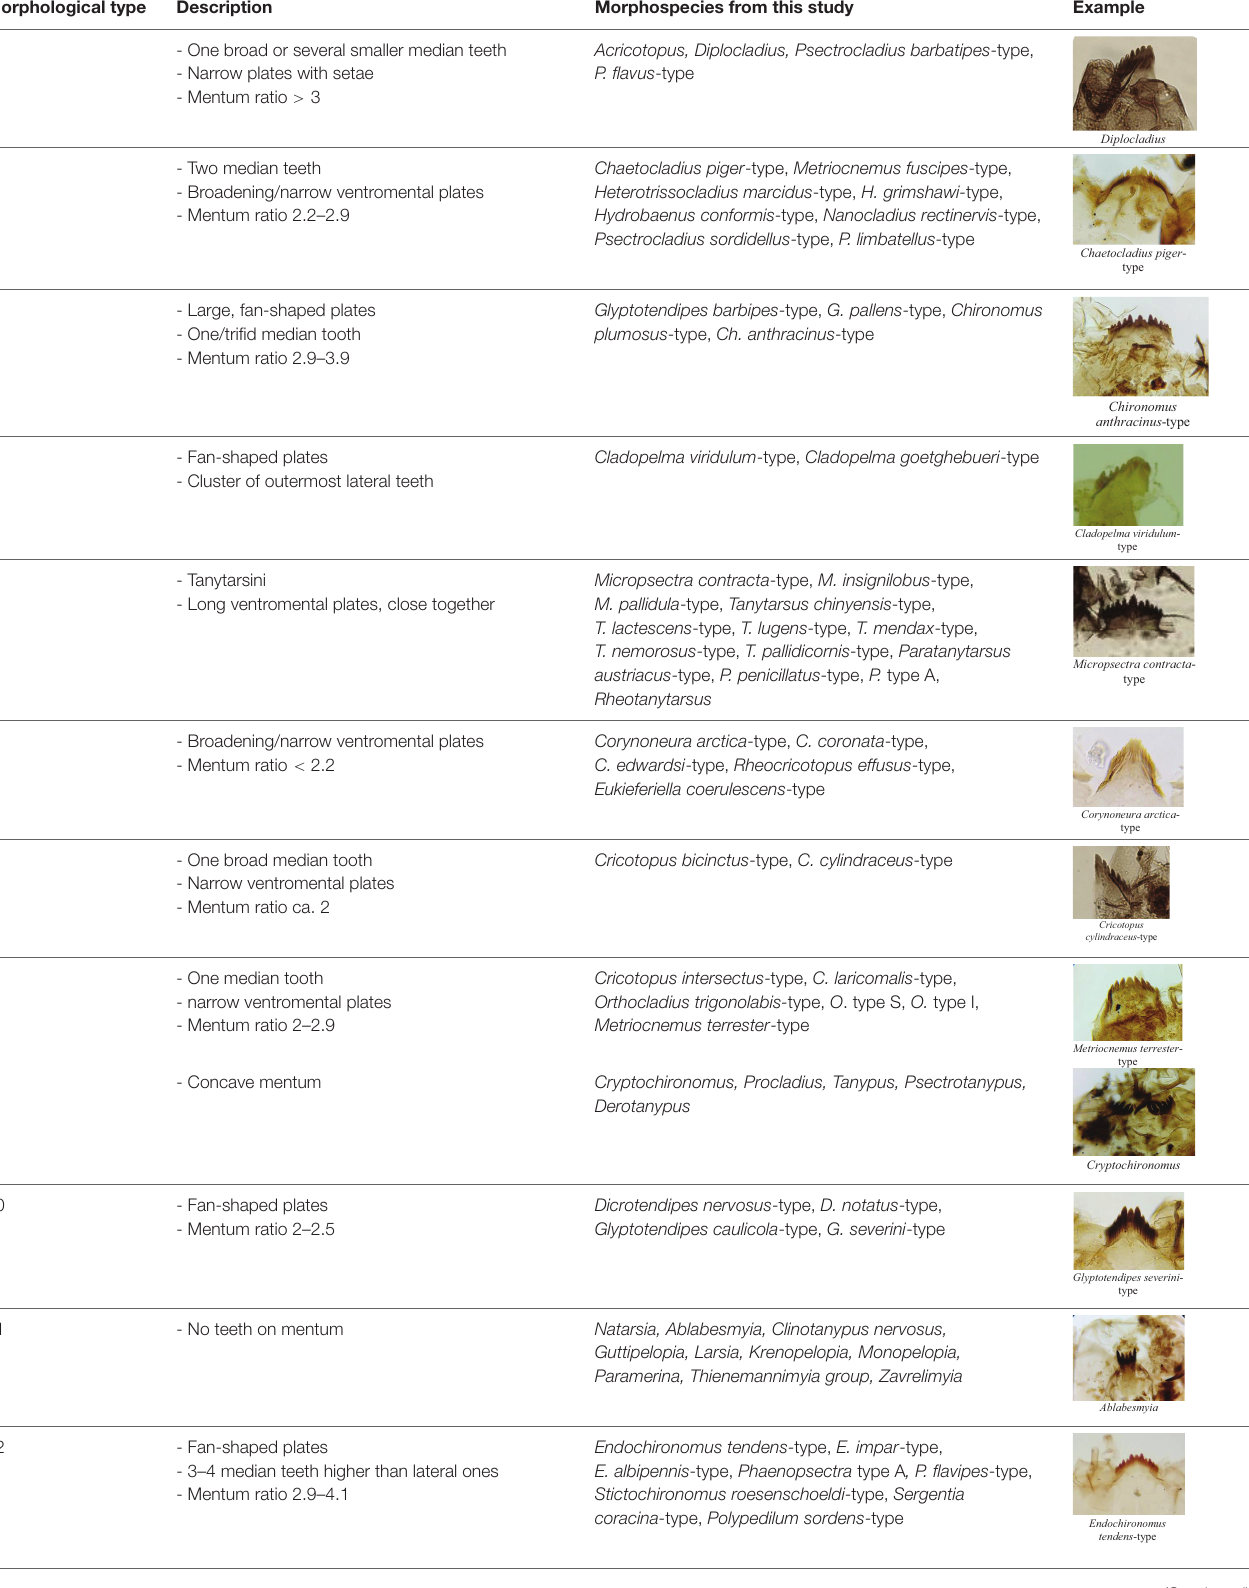
TABLE 1 | Chironomidae morphological